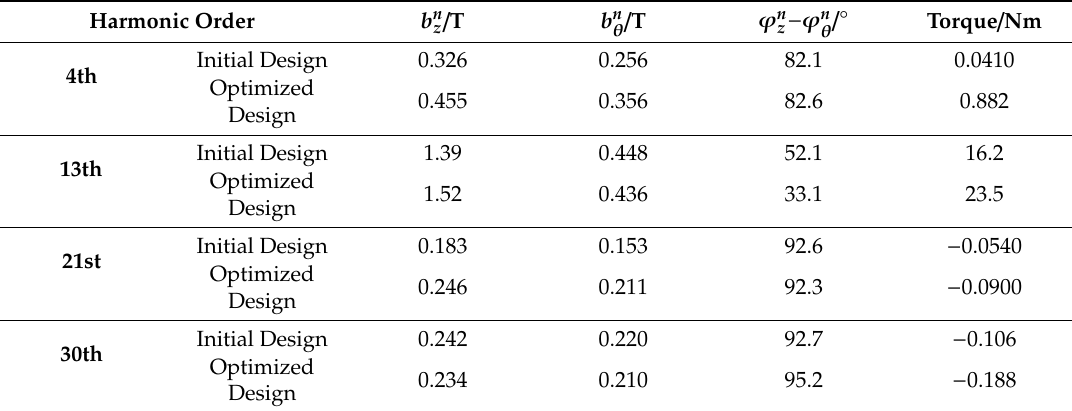
Table 8. Amplitudes, the phase di ff erences and torque due to the air-gap flux density at the radius of R m2 .